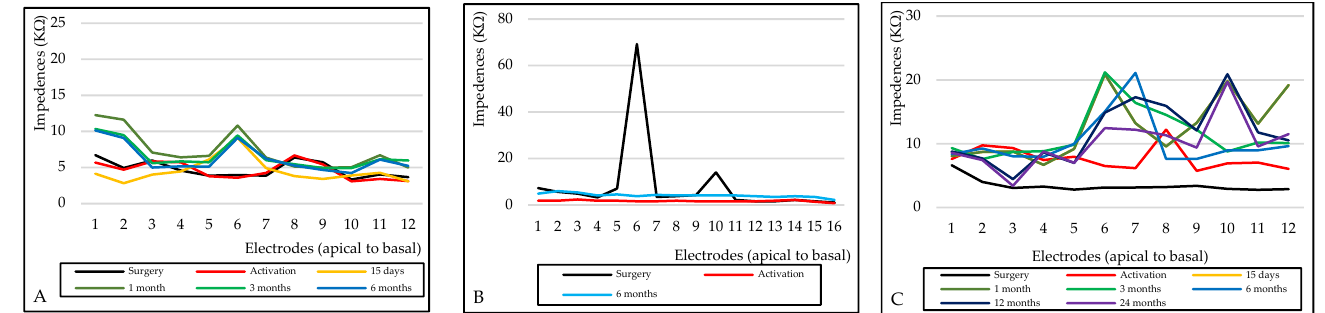
Figure 3. Electrodes’ impedance measurements during the follow-up. ( A ) Patient no. 1. ( B )